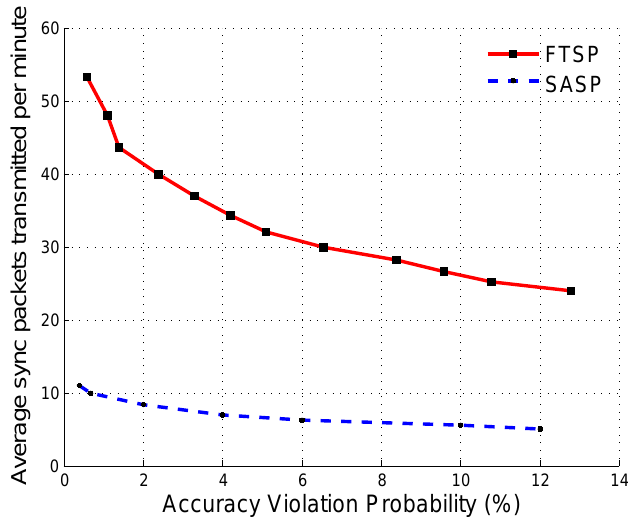
Figure 11. The average synchronization packets transmitted per minute (60 s) for SASP and FTSP under different accuracy violation